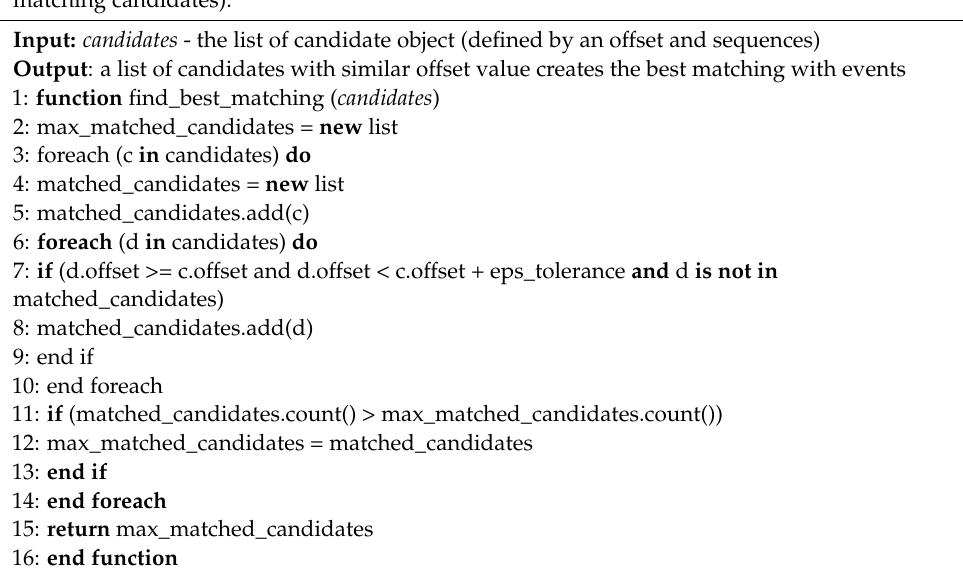
Algorithm 7: Finds the best offset value (the offset value that generates the greatest number of matching